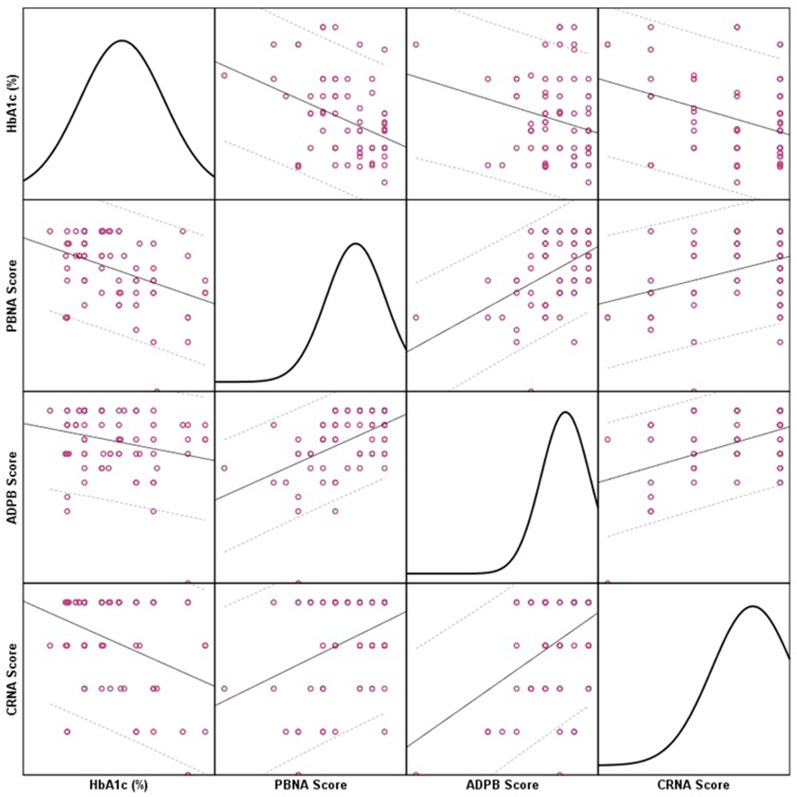
Correlations Between HbA1c and Individual Adherence Scores.